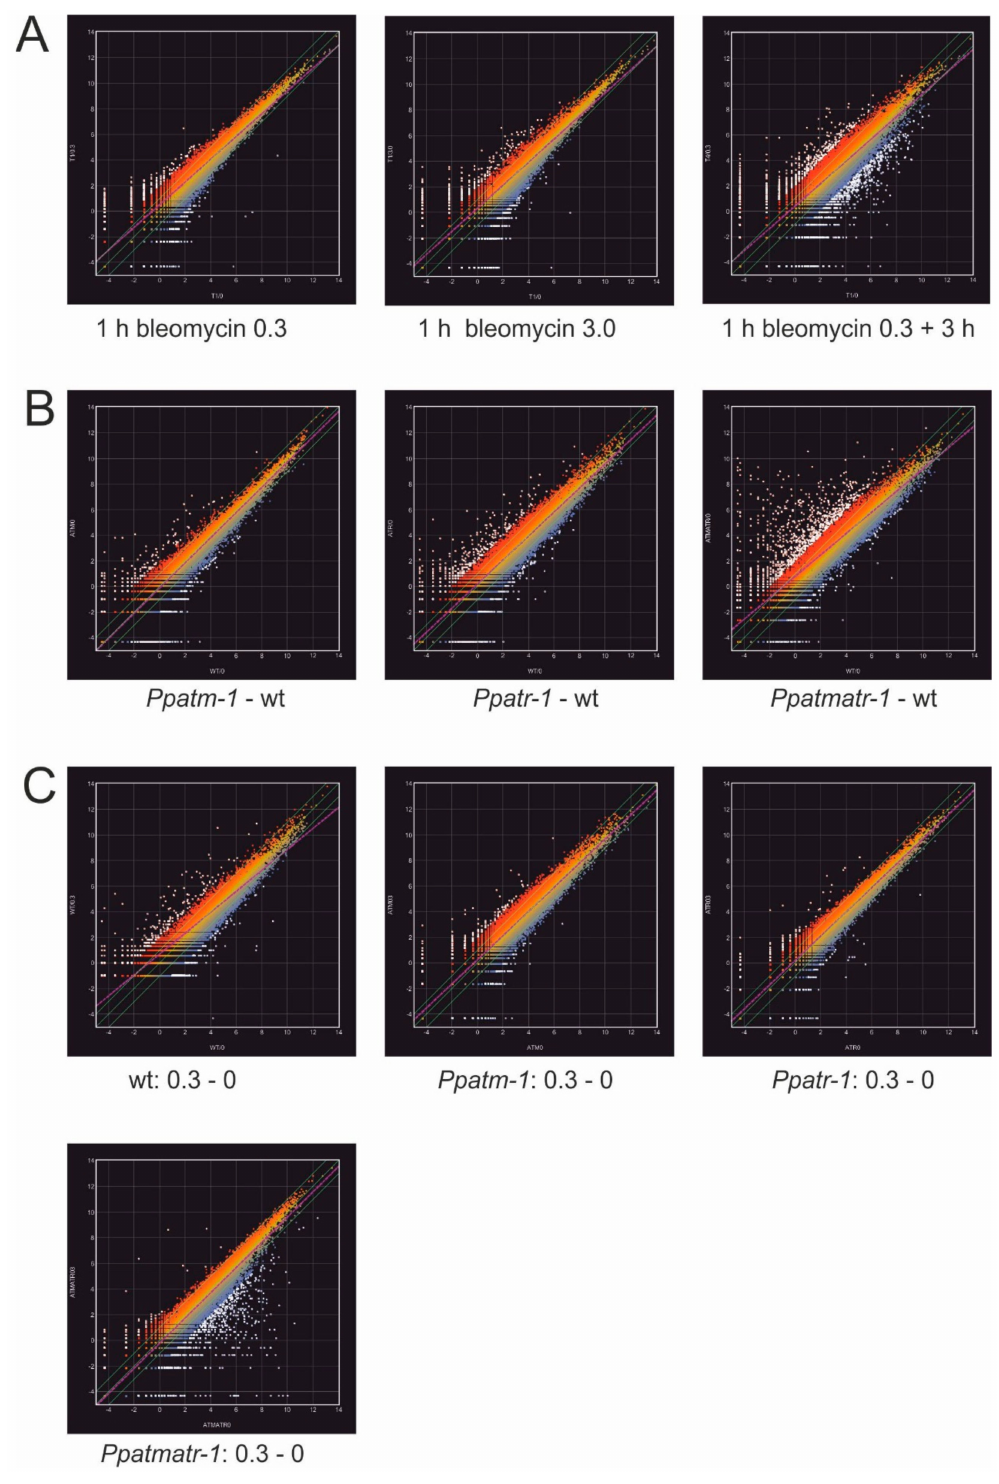
Figure 5. Whole transcriptome SuperSAGE analysis. ( A ) Whole transcriptome analysis of the early response to bleomycin-induced DNA damage. The results of the treatment and mock treatment, respectively, of wild type with lethal (3.0 u / L) and sub-lethal (0.3 u / L) concentrations of bleomycin for 1 hour and the following 3 hour recovery period are shown. The SuperSAGE tags were mapped to P. patens transcripts and had their data normalized, and fold change ratios for the 15561 transcripts in the analysis were calculated. The scatter plots show the following comparisons: 1 h bleomycin 0.3,